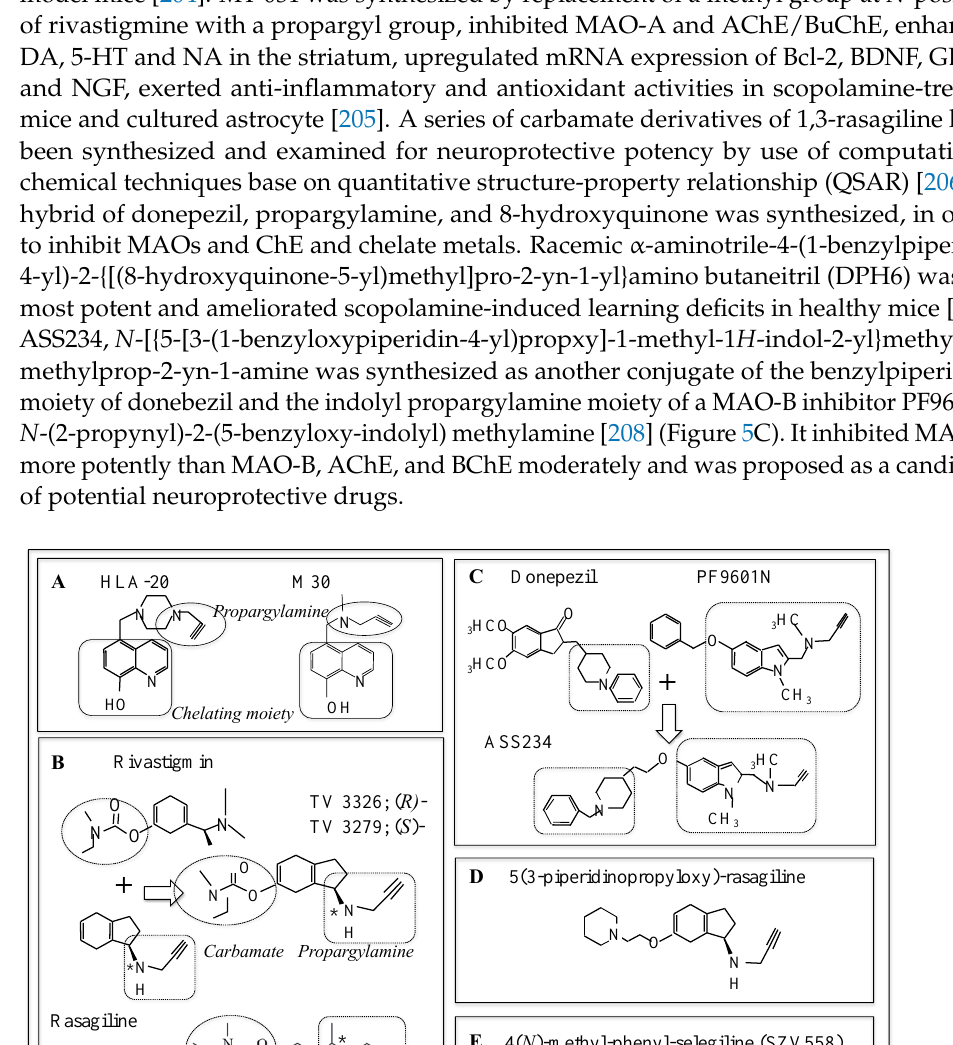
JM olN eurosci(2017)61:498 – 510